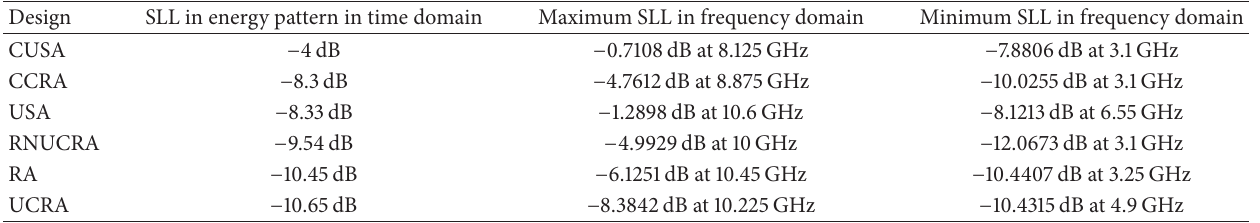
Table 1: SLL values for the TDTD array